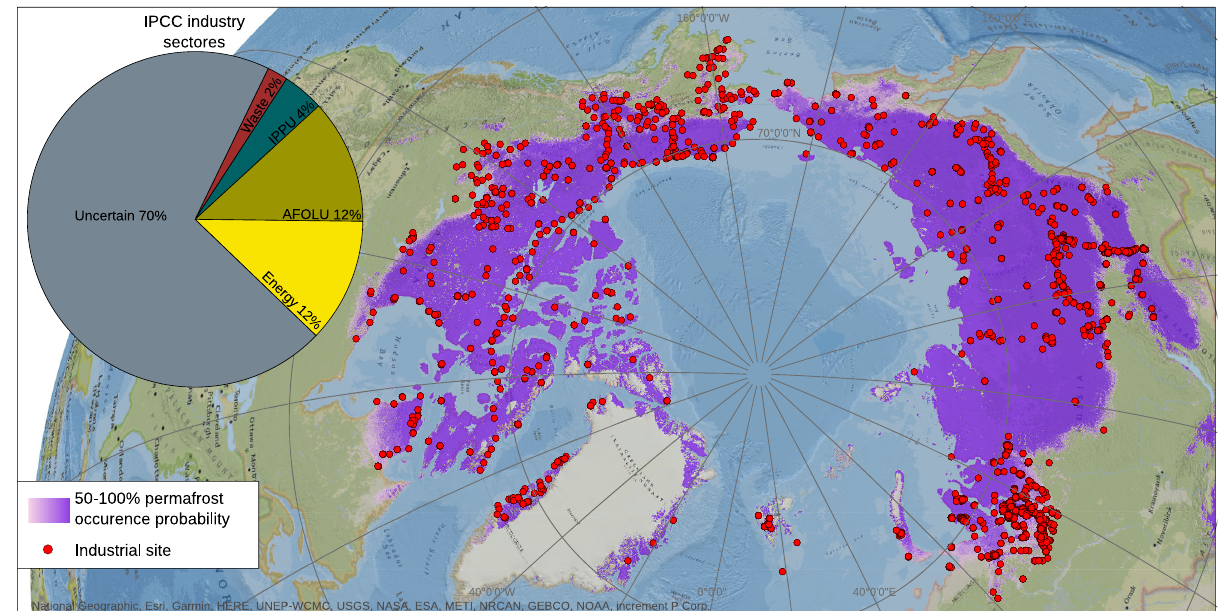
Fig. 2 | Occurrence of industrial sites in permafrost dominated regions of the Arctic. Thepermafrostmodeldomain(permafrostoccurrenceprobability>50%)is delineated based on the Northern Hemisphere Permafrost Map (NHPM) 22 and the database of industrial sites is based on OpenStreetMap (OSM) and the 2019 Nor- dregioAtlasofPopulation,SocietyandEconomyintheArctic(APSEA).Background mapisbasedonthe NationalGeographicWorldMap 58 .While theindustrialsectors